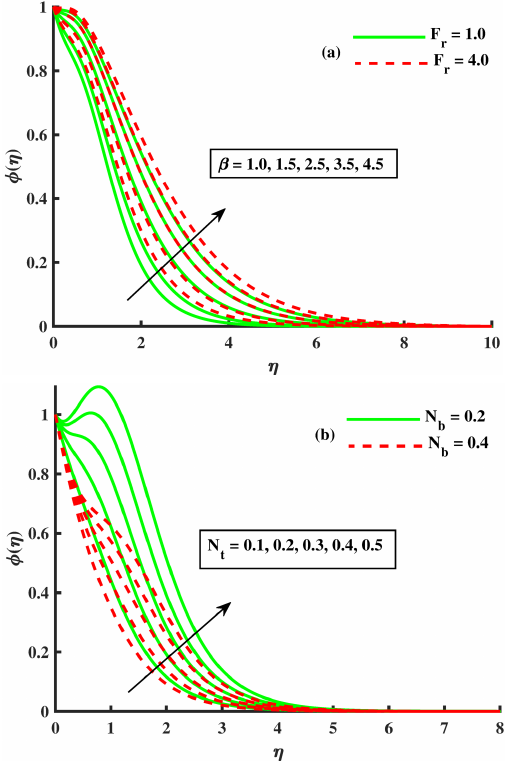
Figure 7. The effects of W e , D , N b , & N t on φ ( η ) .